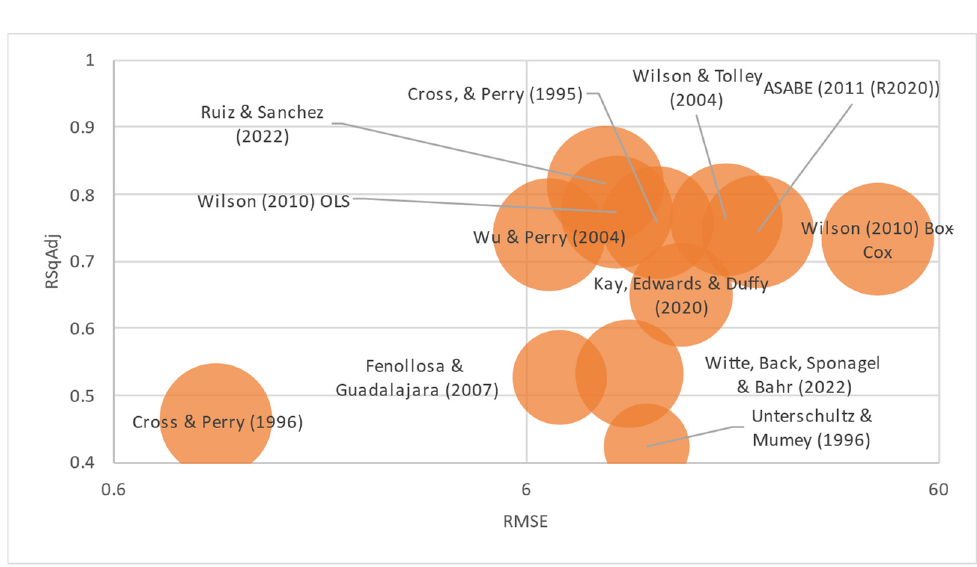
Figure 8. Reults of previously referenced studies (bubble size represents number of observations).